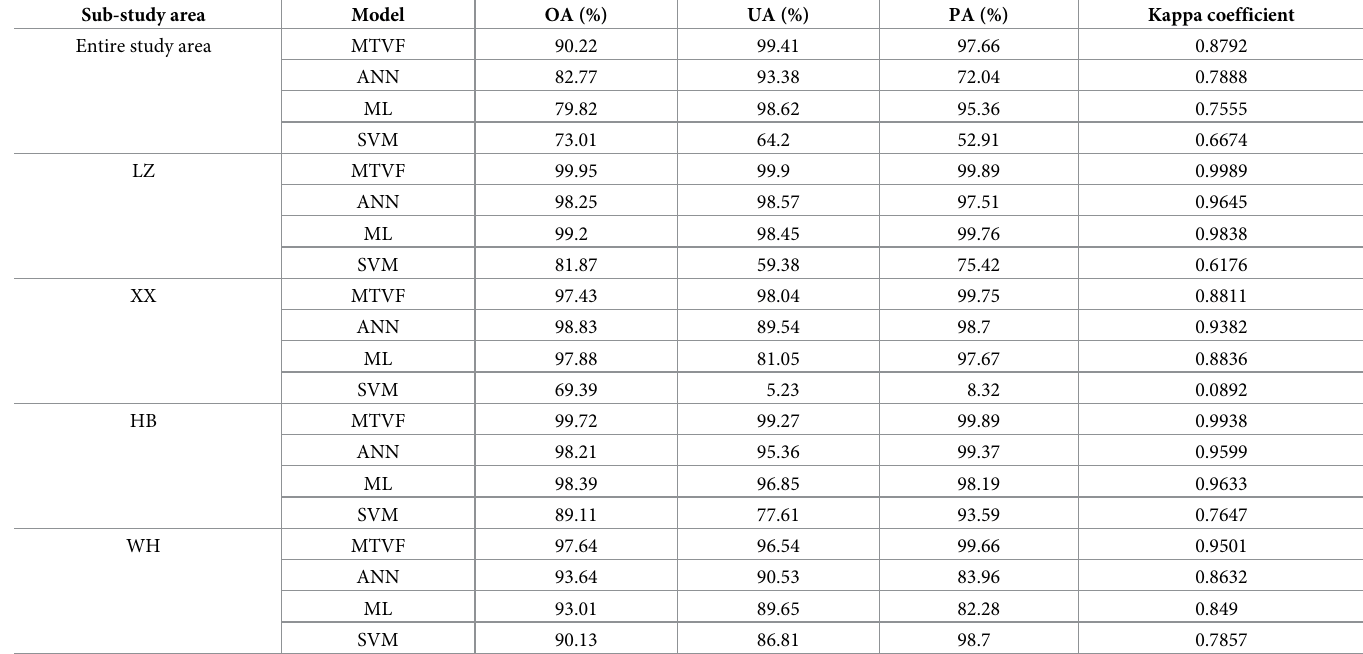
Table 8. Comparison of the accuracies of the MTVF and the other classification models.